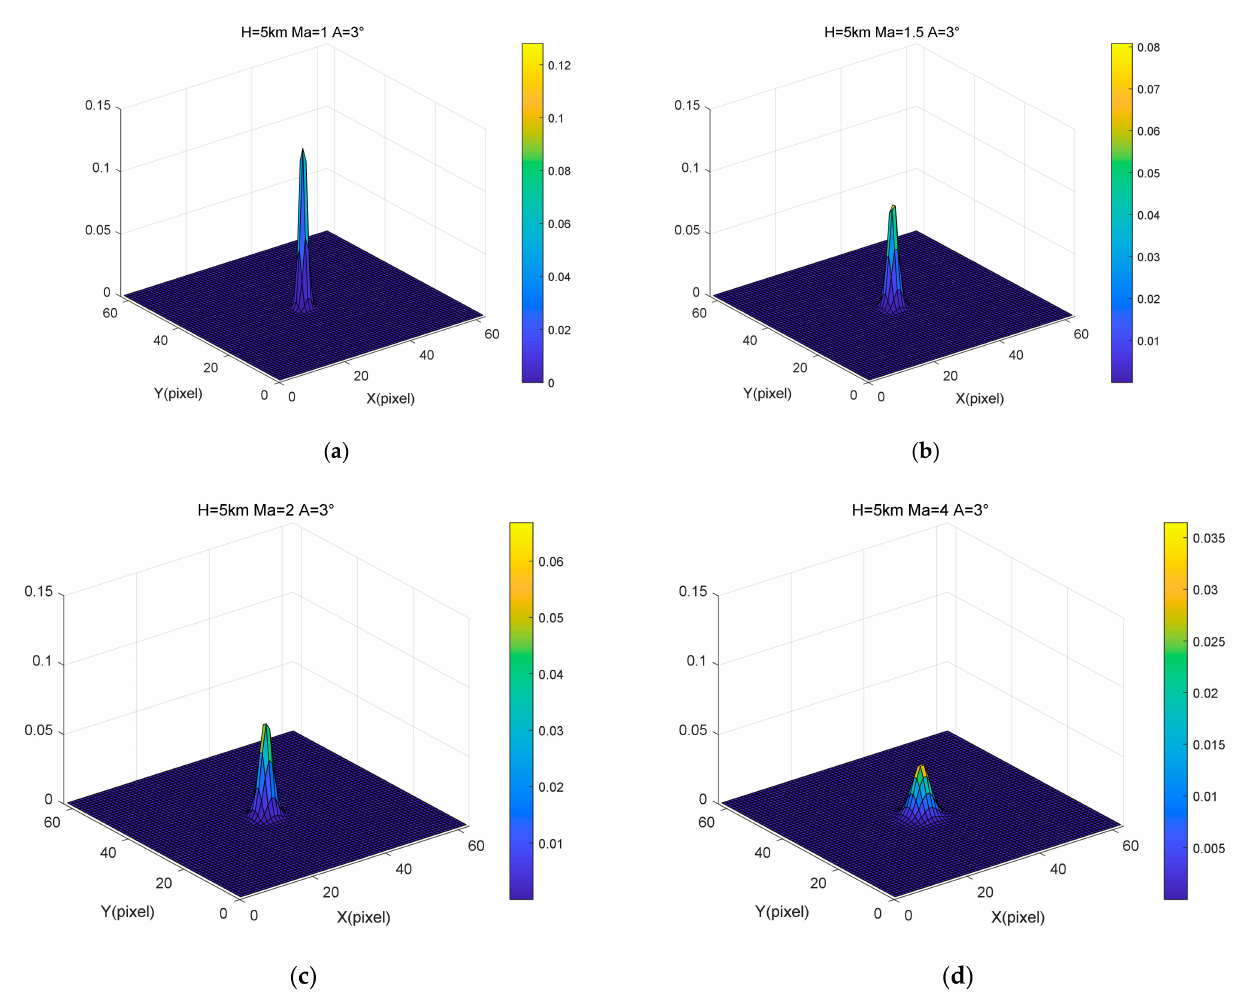
Figure 8. Variations in PSF results with different velocities: ( a ) Mach number = 1, Angle of attack = 3 ◦ , Height = 5 km, ( b ) Mach number = 1.5, Angle of attack = 3 ◦ , Height = 5 km, ( c ) Mach number = 2, Angle of attack = 3 ◦ , Height = 5 km, ( d ) Mach number = 4, Angle of attack = 3 ◦ , Height = 5 km.